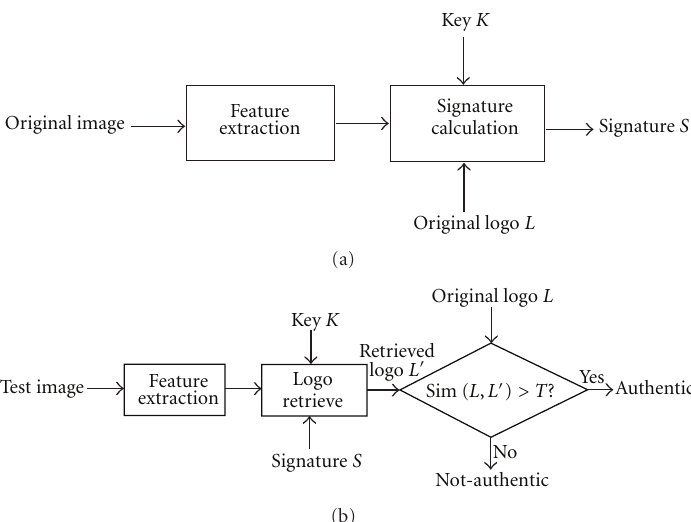
Figure 1: Signature-based scheme using logo: (a) signature calculation and (b) logo retrieval operation and verification.